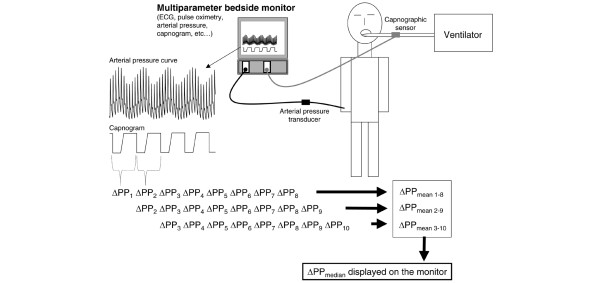
Automatic calculation of variation in arterial pulse pressure (ΔPP) from the recordings of arterial pressure and capnographic signals on a regular bedside monitor.